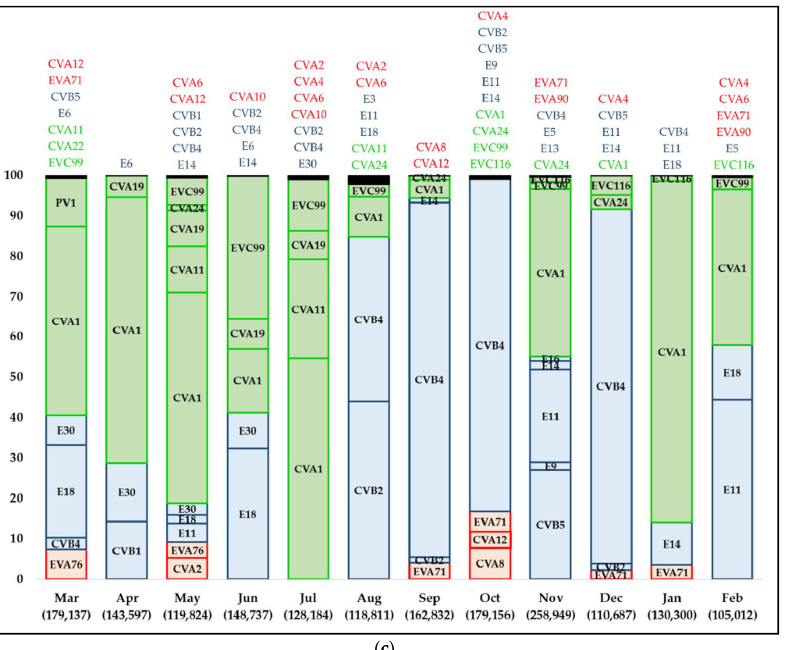
Figure 1. Abundance of contigs mapping to different Human Enteroviruses types/species in wastewater samples monthly collected in Córdoba City (Argentina) during 2011 ( a ), 2012 ( b ), and 2017–2018 ( c ). The bar-graphs show the relative abundance in percentage of contigs mapping to different Human Enteroviruses types for each sample. Types represented by less than 1% of the mapped contigs, abundances which are accumulated in a black portion, appear named and colored according the species at the top of each bar. Types belonging to species A are in red, to species B in blue, and to species C in green. Samples from March, May, September, and October 2012 were not assayed (NA) due to low volumes of available viral concentrates. The total number of contigs mapping to Human Enteroviruses is indicated between parentheses for each sample. CVA: coxsackievirus type A; CVB: coxsackievirus type B; E: echovirus; EVA: enterovirus type A; EVB: enterovirus type B; EVC: enterovirus type C; PV: poliovirus. Table 1. Variation in the abundance and efficiency of the typing process for contigs obtained by next-generation sequencing of Human Enteroviruses detected in wastewater samples.